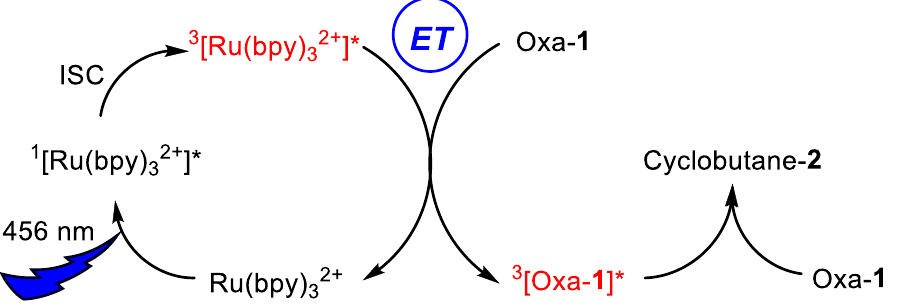
Figure 10. Proposed mechanism for the formation of the reactive species of the oxazolone 3 [oxa- 1 ]* by photosensitization of the oxazolone in the ground state oxa- 1 from 3 [Ru(bpy) 32+ ]* by energy transfer. Further reaction of 3 [oxa- 1 ]* with oxa- 1 affords the cyclobutanes 2 .